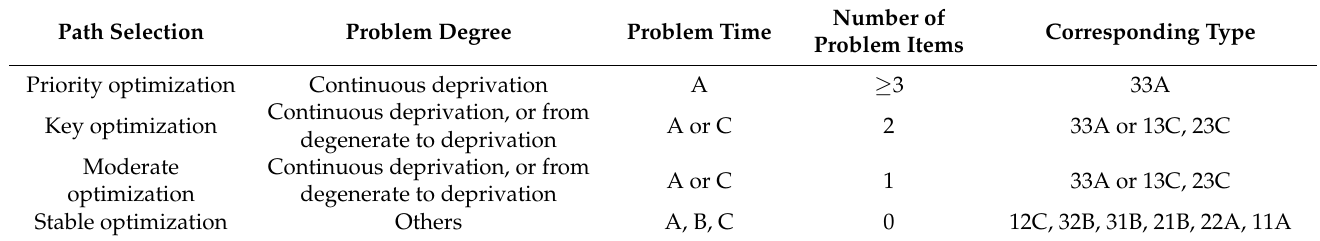
Table 3. Path design of function optimization of rural residential land based on problem